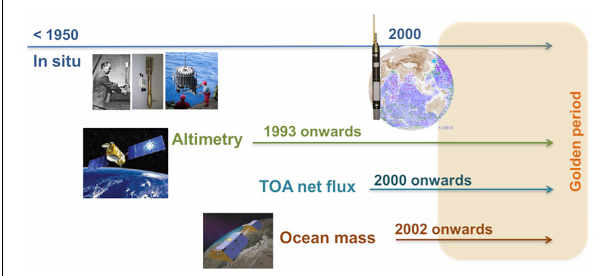
FIGURE 1 | Schematic representation of the evolution of in situ and remote sensing observing systems for the evaluation of global ocean heat content. The shaded area indicates the so-called “golden period” of Earth system measurements for global ocean heat content estimates, which starts circa 2005 and is characterized by initially sparse but steadily improving global coverage of in situ temperature measurements through the Argo